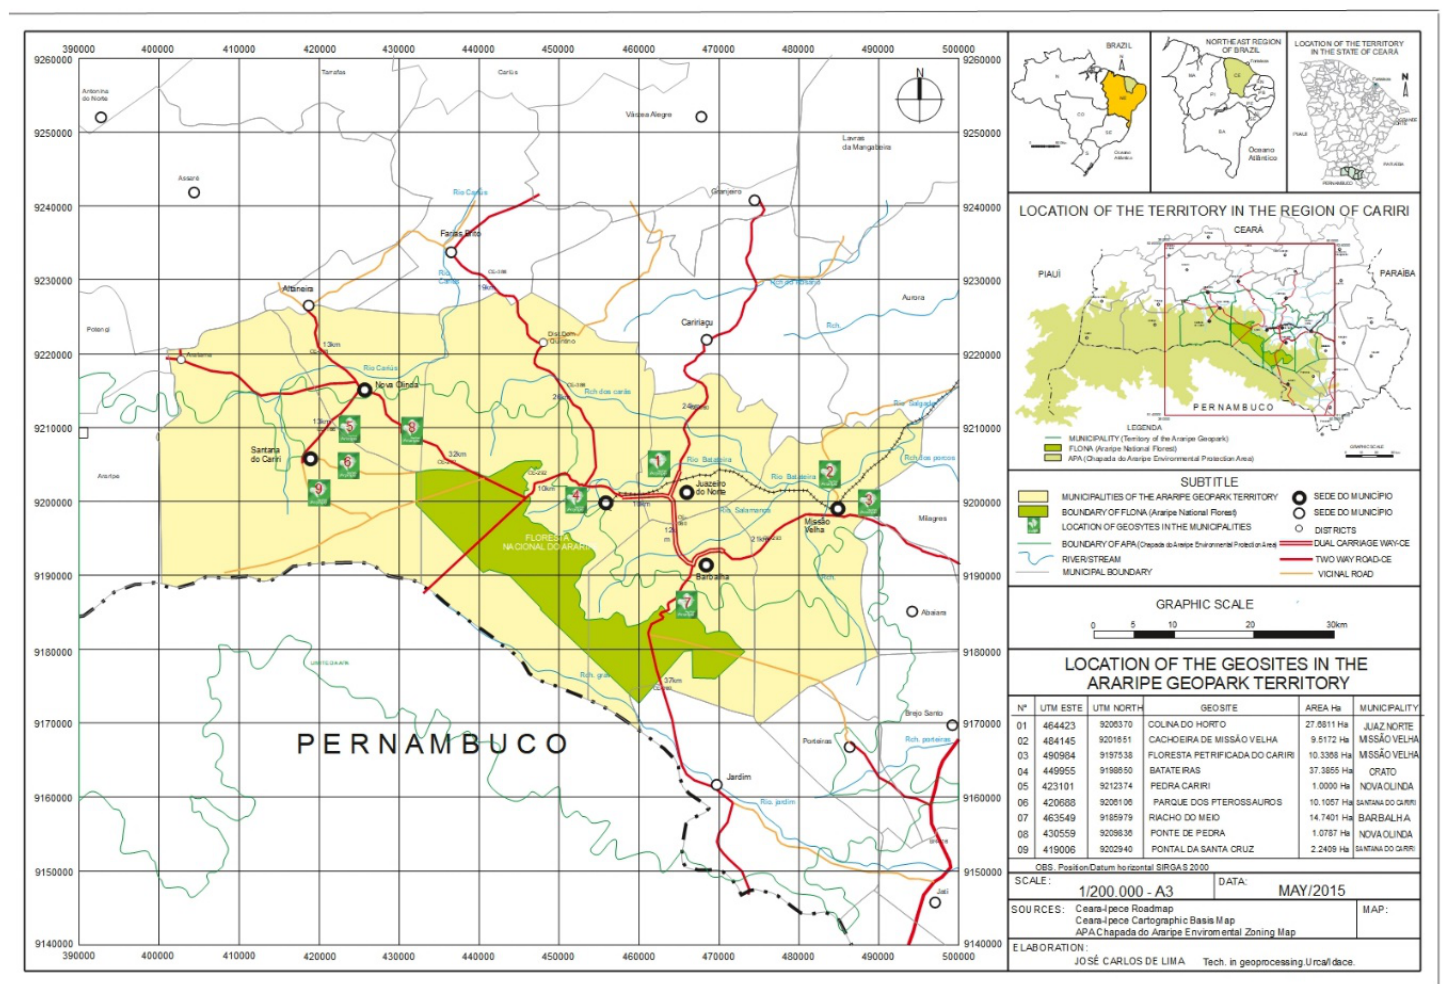
Figure 1. Map of the territory of Araripe UNESCO Global Geopark. Source: Araripe Geopark Database, March 2018; adaptation allowed for this research